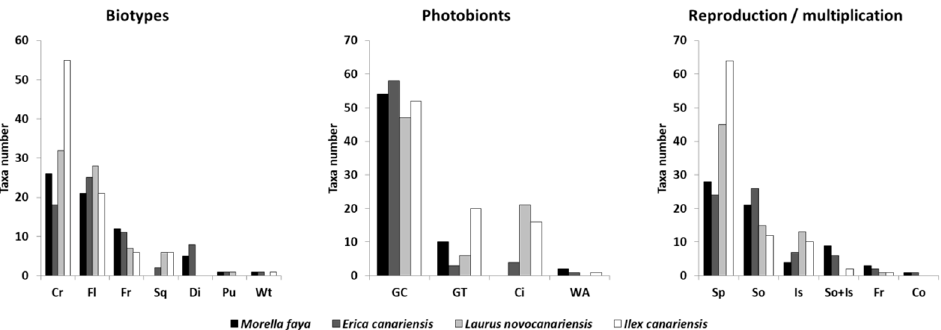
Figure 4. Morphological traits of lichen in Morella faya (black bars), Erica canariensis (dark gray bars), Laurus novocanariensis (gray bars), and Ilex canariensis (white bars); biotypes: Cr: crustaceous, Fl: foliose, Fr: fruticose, Sq: squamulose, Di: dimorphic, Pu: pulverulent/leprose, Wt: without thallus; photobionts: GC: green clorococcoid algae, GT: Trentepohliaceae algae, Ci: cyanobacteria, WA: without algae; and reproduction/multiplication: Sp: spore, So: soredia, Is: isidia, So + Is: soredia and isidia, Fr: fragmentation, Co: conidia.